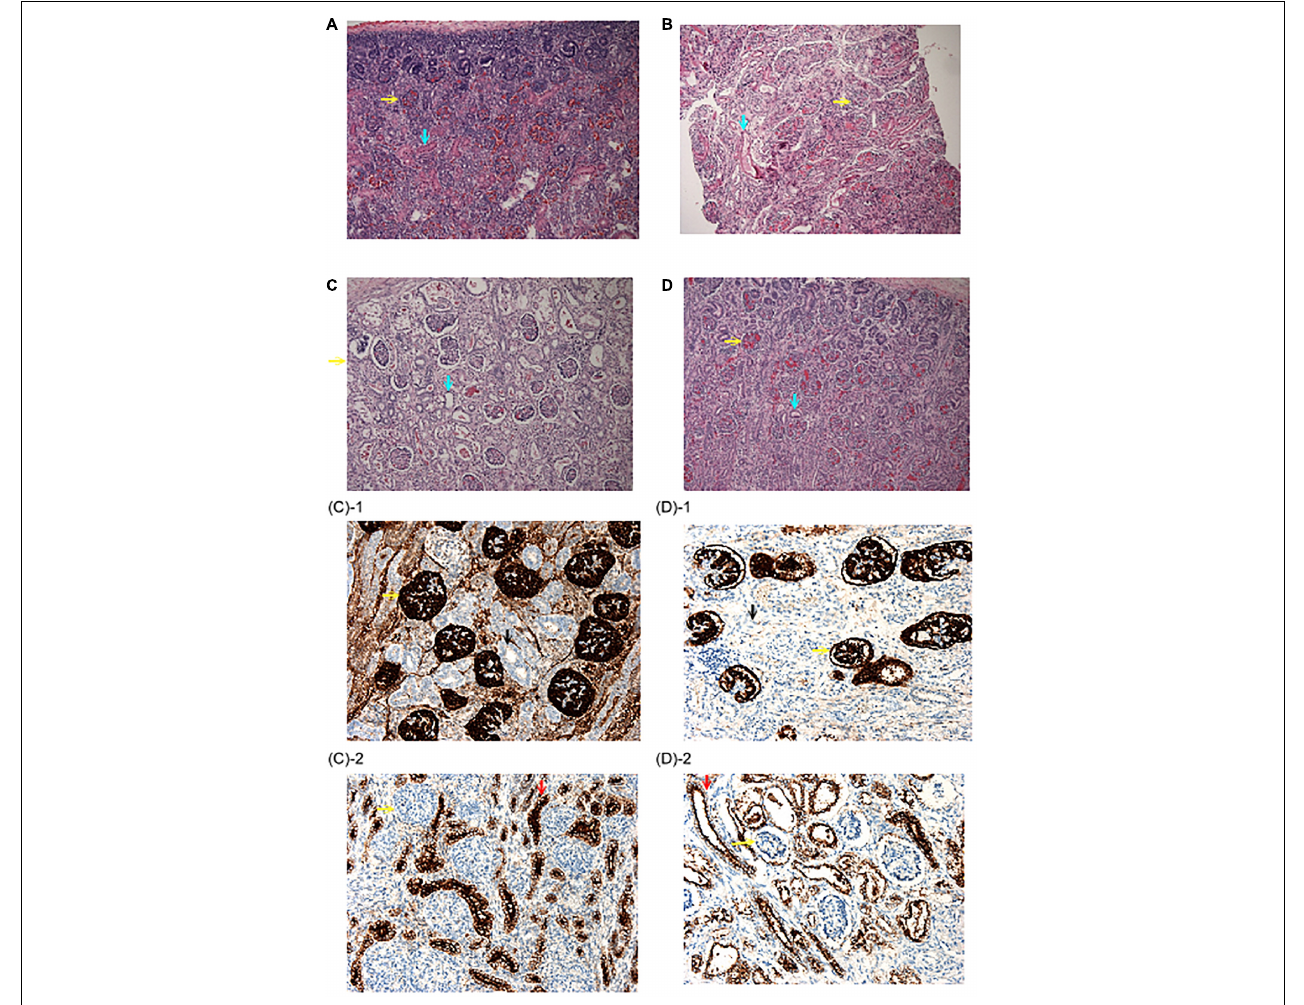
FIGURE 2 | Renal histopathological findings. (A) Autopsy renal section from a fetus at 22 weeks due to congenital diaphragmatic hernia. Abundant proximal tubules were noted as the normal control. (B) Biopsy renal section from the patient 2–2 in family 2. Note that although proximal tubules could be seen, the cells were flat and had low cellularity. (C,D) Autopsy renal sections from the patient 1–1 and 1–2 in family 1. No well-developed proximal tubules could be identified. (H&E stain, original magnification: 100X) (C-1,D-1) were stained with anti-CD 10 antibody and no proximal tubules were illustrated. (C-2,D-2) Were stained with an anti-EMA antibody, which was positive for distal tubules. (Original magnification: 200X) Yellow arrow: Glomeruli; Blue arrow: proximal tubules; Black arrow: anti-CD 10(–) tubules; Red arrow: anti-EMA (+) distal